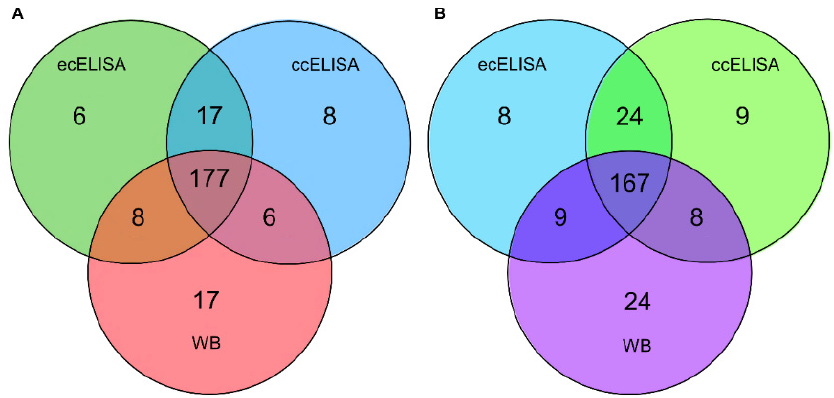
Figure 7. Venn diagram showing summary results of serological detection methods (newly estab-